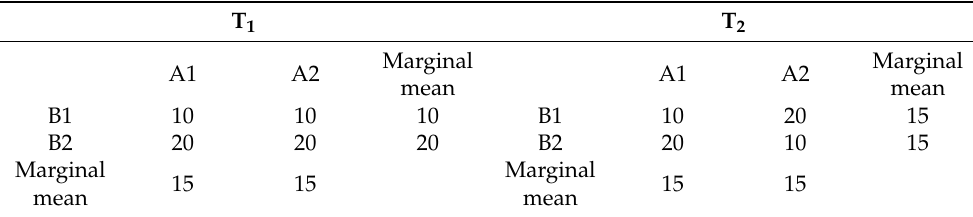
Table 1. Results of the experiment T 1 and T 2 .